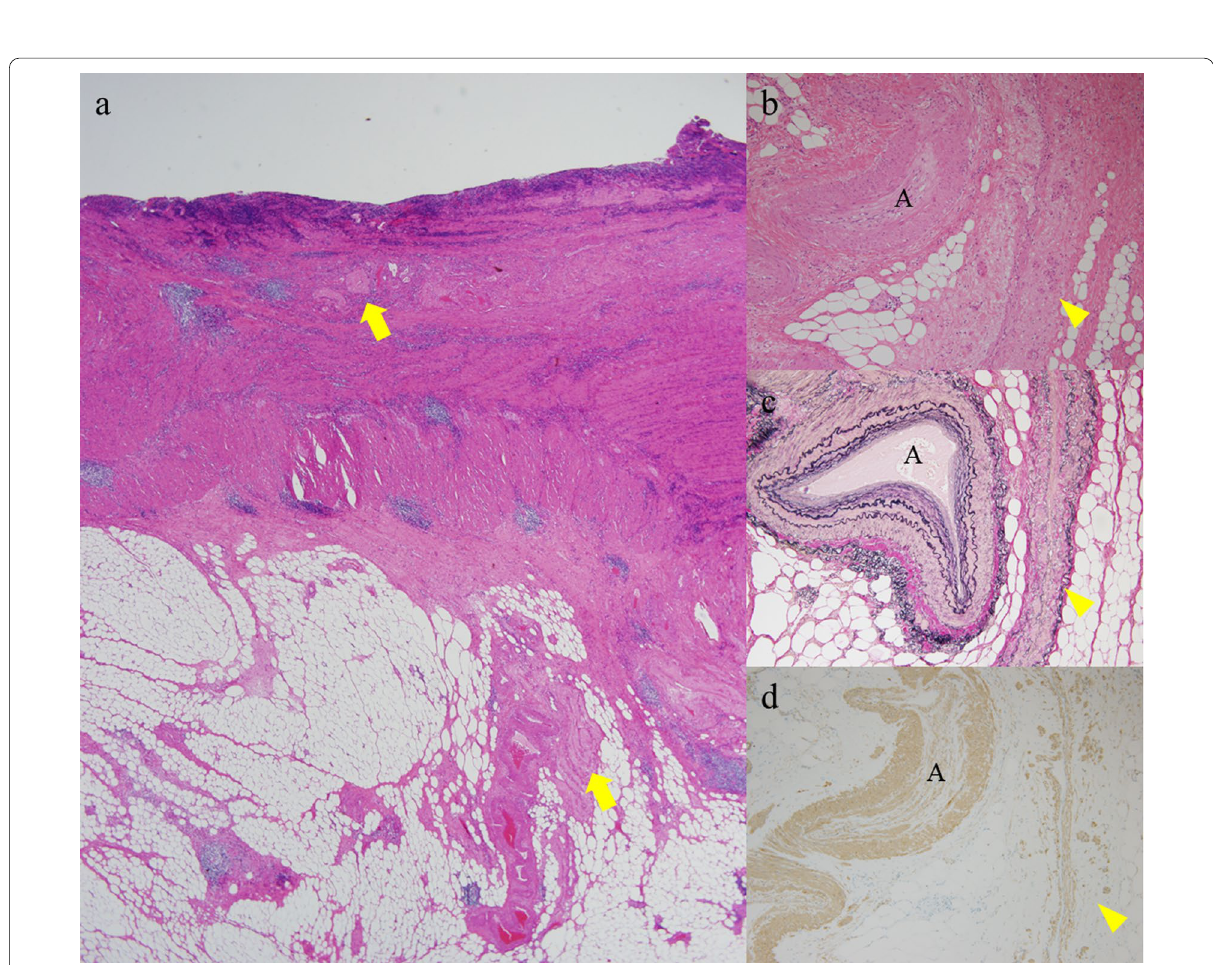
Fig. 5 Histopathological findings of the ischemic lesion of the small bowel. Venous wall from the mesentery to the submucosa showed degeneration (arrows) that caused ulceration and some other ischemic changes in the affected mucosa ( a HE, degeneration, decrease in the number of smooth muscle cells, and narrowing of the lumen (arrowhead). The accompanying artery was patent; however, mild sclerotic changes were observed (A) ( b HE,